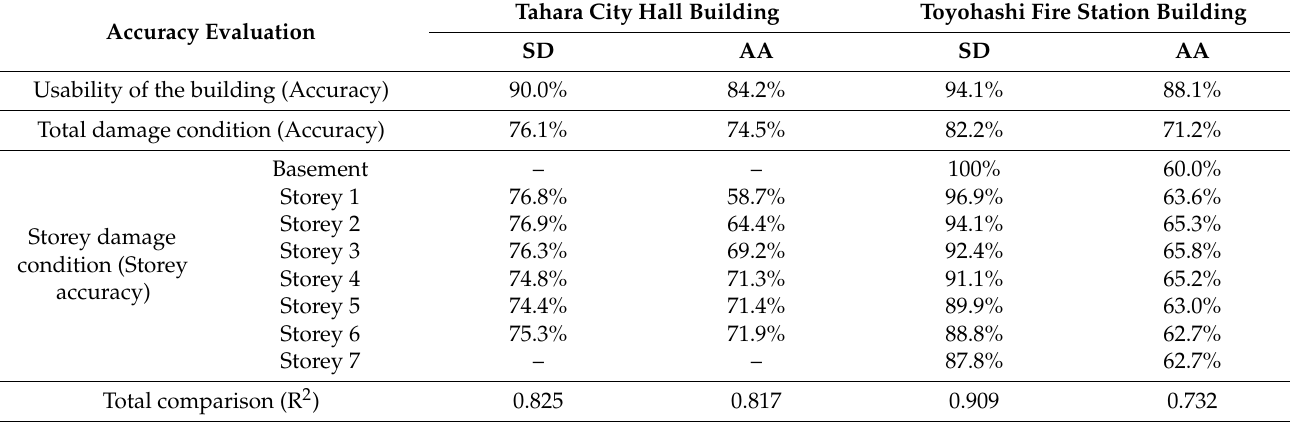
Table 3. Evaluation accuracy of target